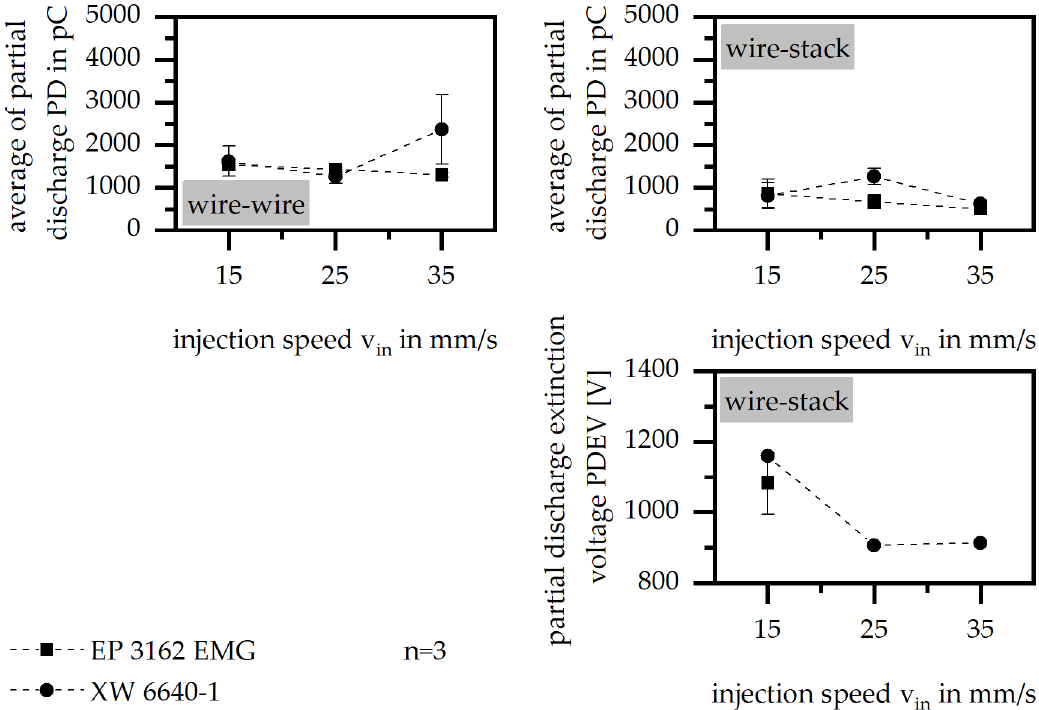
Figure 8. Average of partial discharge (PD) and partial discharge extinction voltage (PDEV) relative to the injection velocity in the insulation system of wire to wire and wire to stack.